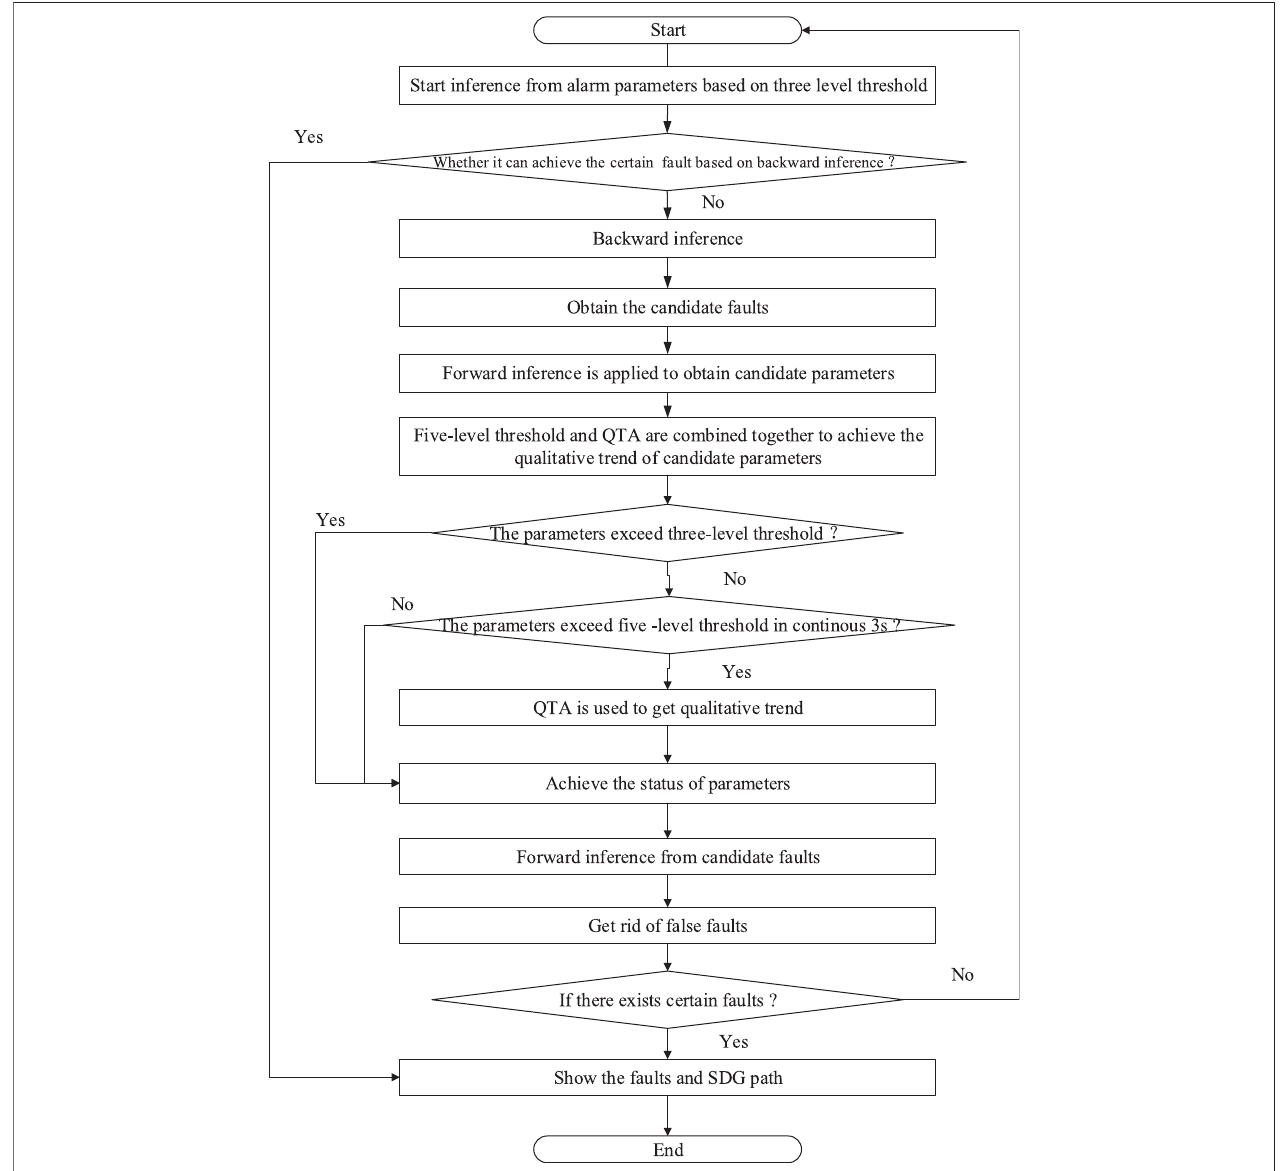
FIGURE 6 | Flow chart of process monitoring and